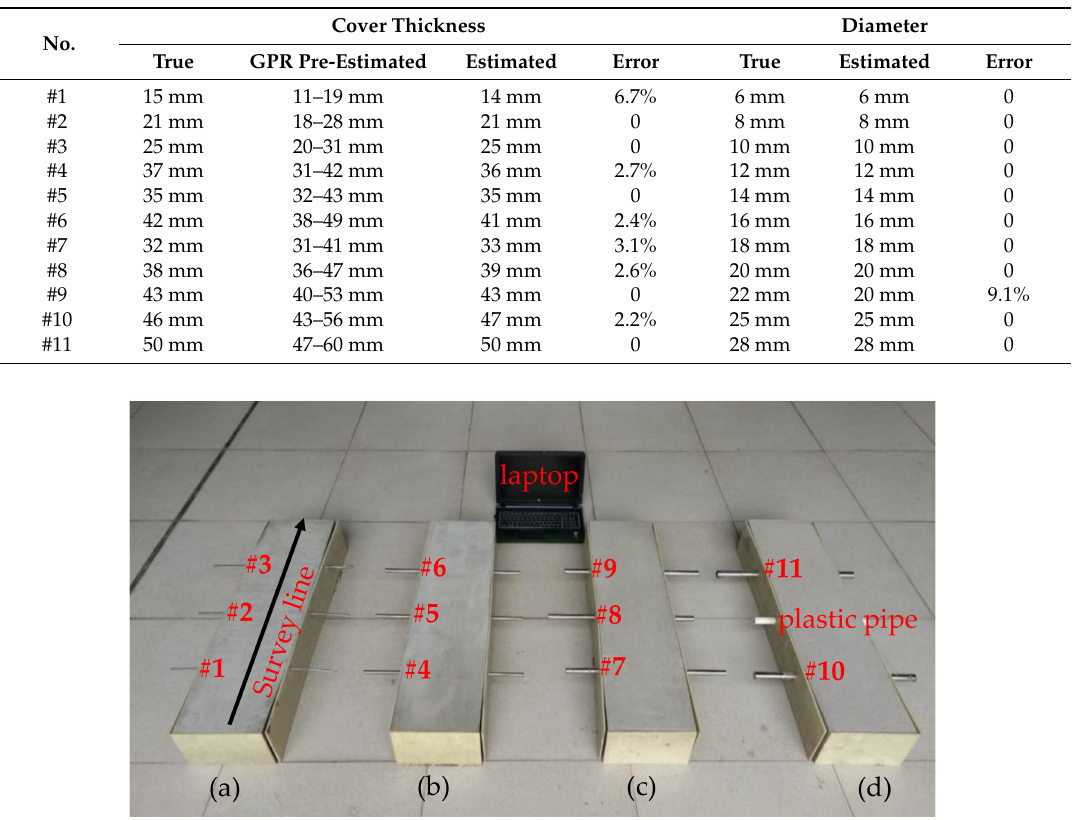
Figure 8. The four cast concrete specimens ( a – d ) with 11 steel rebars and one plastic pipe embedded